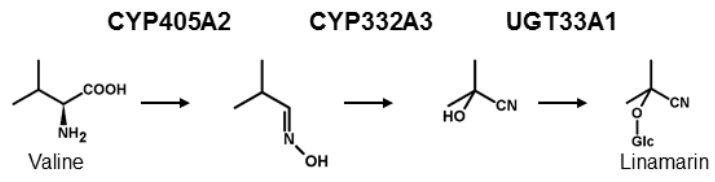
Figure 1. Biosynthesis of CNglcs exemplified by the aliphatic CNglc linamarin and the characterised enzymes from Z. filipendulae .